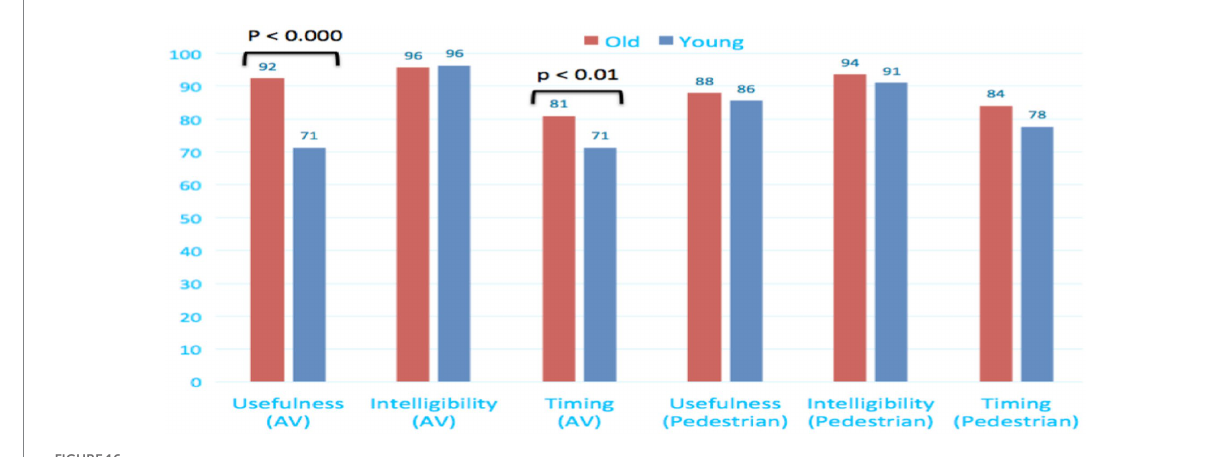
FIGURE 16 Evaluation of the eHMI usefulness, intelligibility and